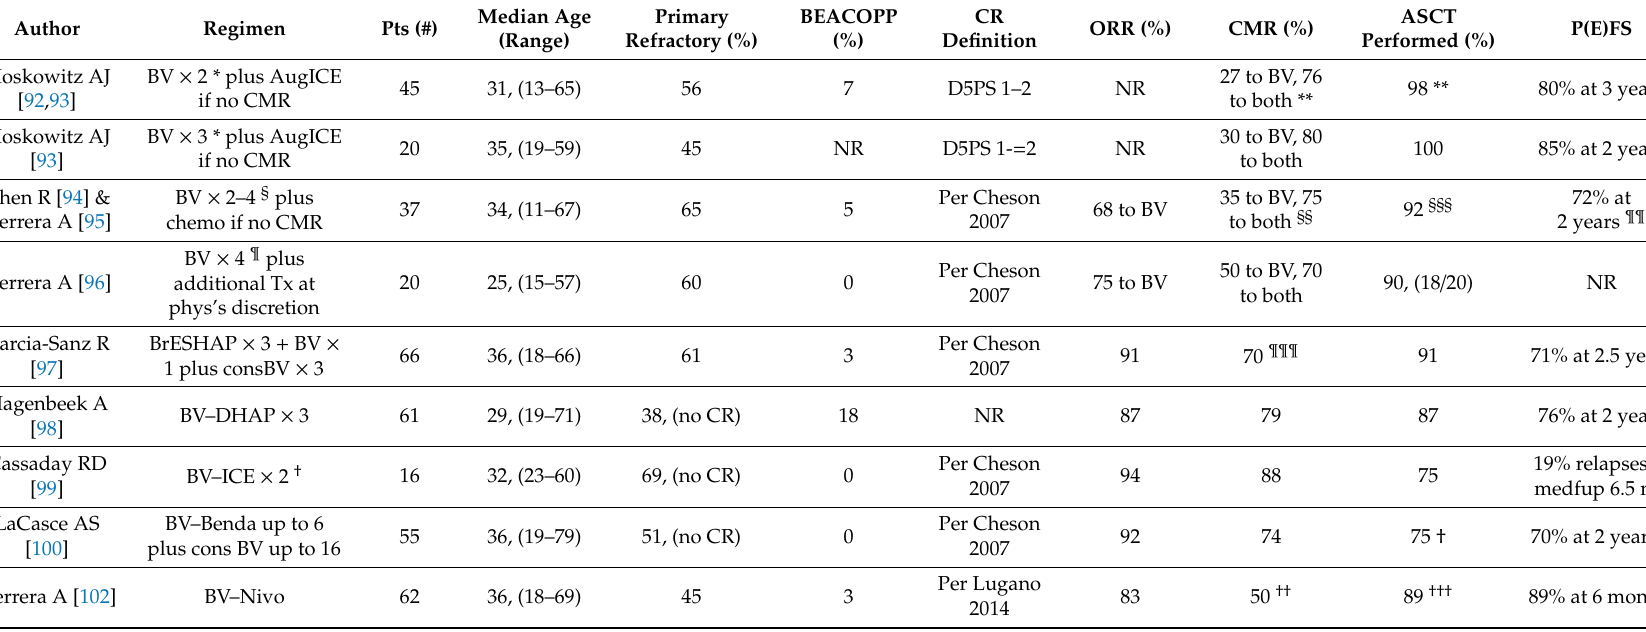
Table 6. Summary of clinical trials combining brentuximab bedotin with salvage regimens (typically used to mobilize stem cells) prior to autoSCT either in sequential or concurrent